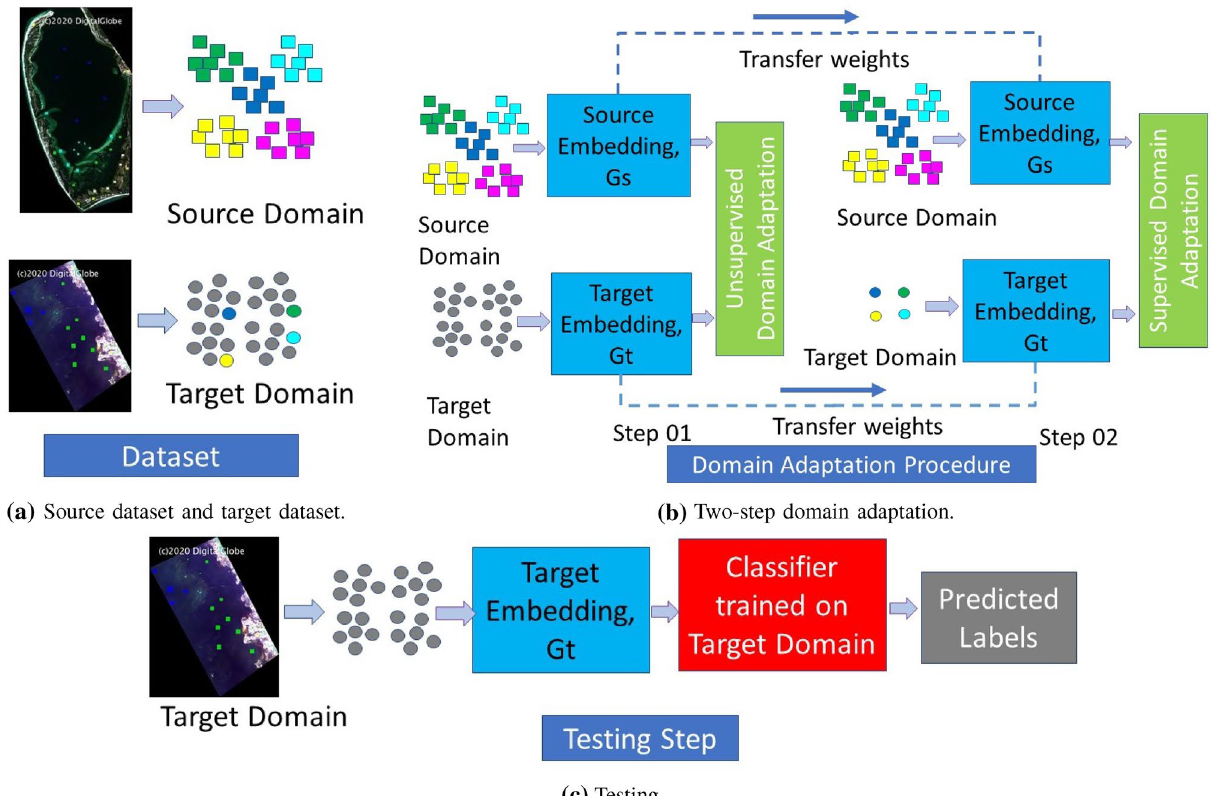
Fig. 1 Diagram of the proposed domain adaptation model for sea- grass detection. a Datasets from both domains where colored sam- ples are labelled, while gray samples are unlabelled. b Unsupervised